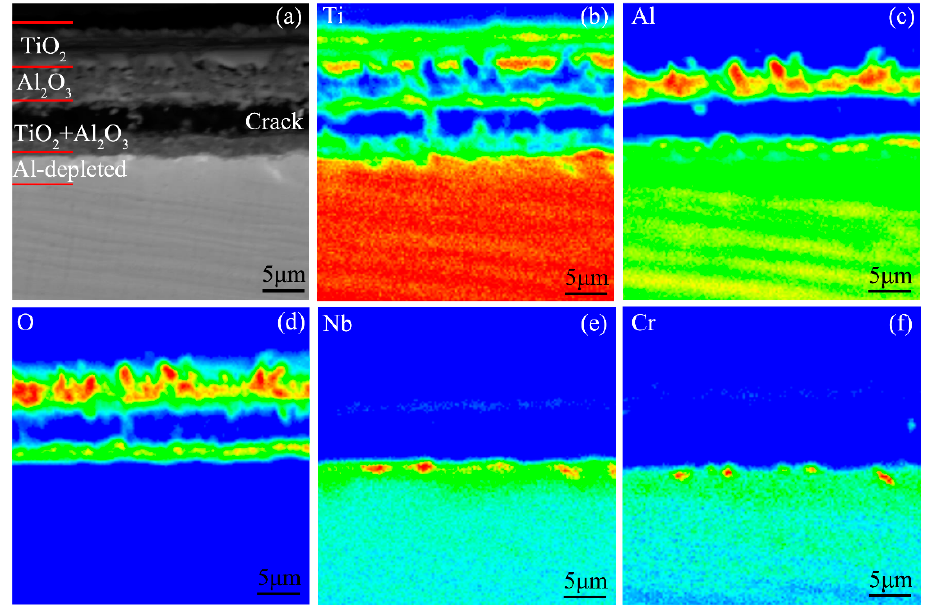
Figure 7. ( a ) Cross-sectional morphology and ( b – f ) the corresponding elemental distribution maps